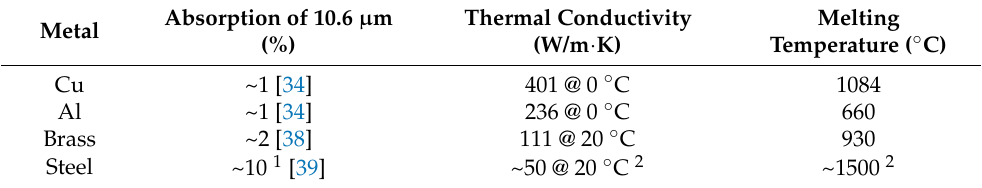
Table 1. Optical and thermal characteristics of the metals used as the cooling base.